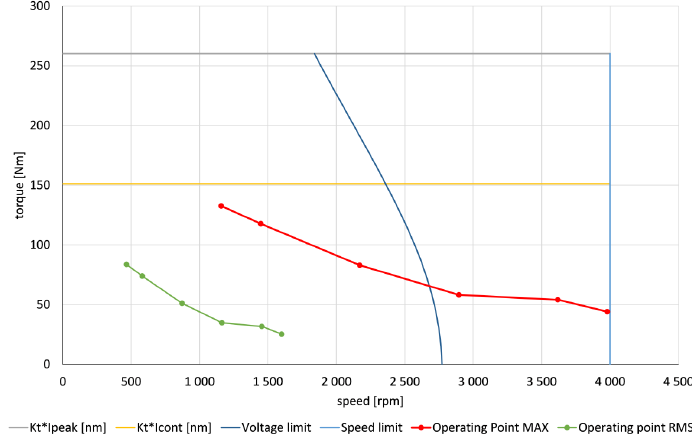
Figure 9. The results of calculations of the motor selection program for the main tower crane drive along with the drive limiting characteristics.